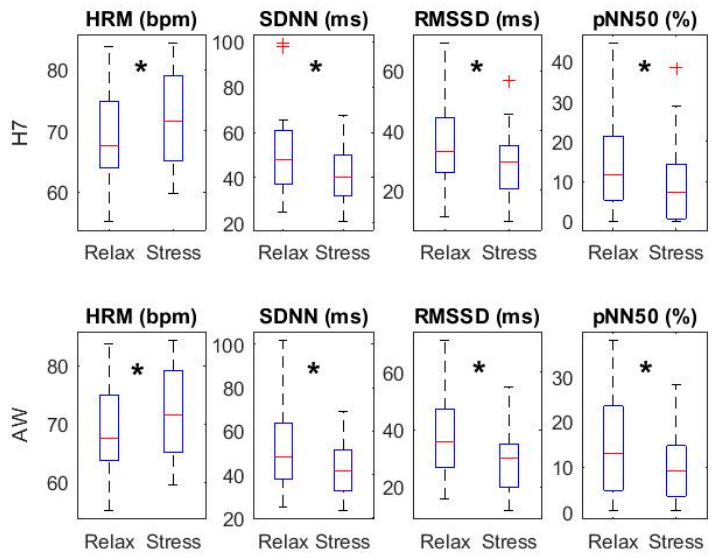
Figure 5. HRV parameters: temporal domain (Relax vs. Stress). * denotes significant differences ( p < 0.05) between adjacent boxplots.